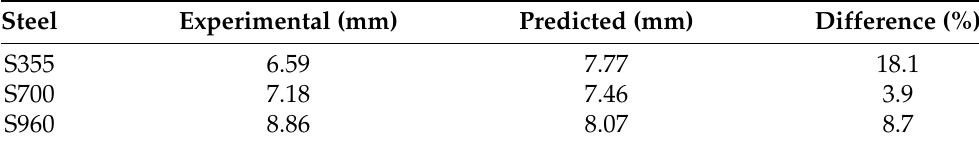
Table 1. Bhatti’s